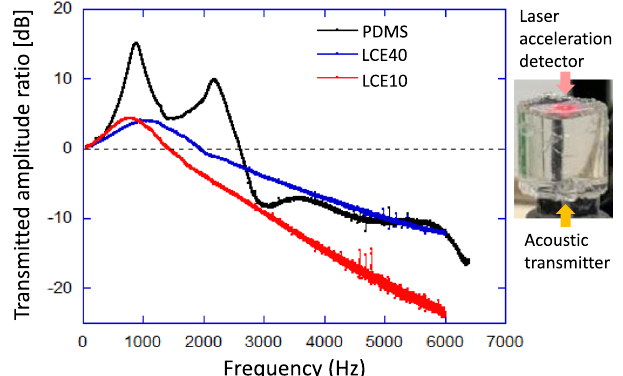
Fig. 4 Vibration attenuation test. The amplitude of the signal (measured in [dB] as a ratio to the incident amplitude) transmitted through the elastomer cylinder is plotted against the vibration frequency. The primary standing wave resonance near 1 kHz is found in all materials, with underdamped PDMS showing several secondary resonance peaks. The overdamped LCE systems have the Q -factor equal to 0.4 (i.e. the damping ratio ζ = 120%), compared with PDMS: Q = 2.4 ( ζ = 21%). Supplementary Fig. S4 shows graphical representations of resonance